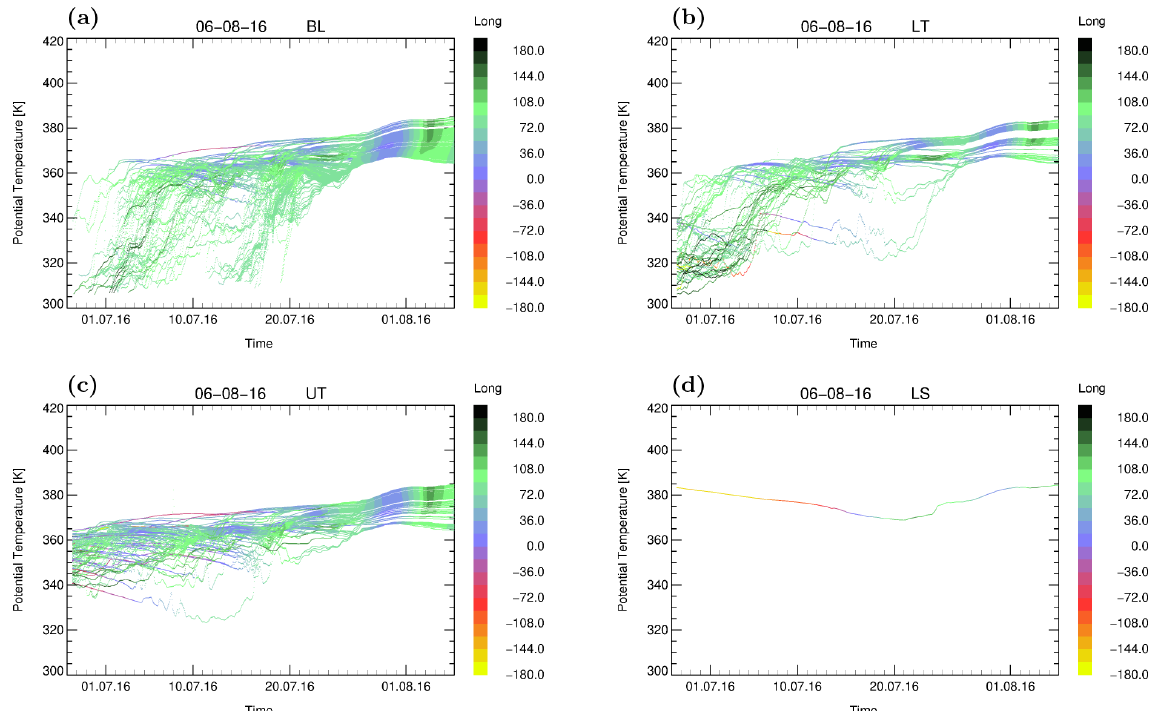
Figure 4. Forty-day backward trajectories initialised on 6 August 2016 at the location of the ATAL measurement (see Table 1). The trajec- tories are sorted by air mass origin in the boundary layer (a) , in the lower troposphere (b) , in the upper troposphere (c) and in the lower stratosphere (d) . The fractions of the different atmospheric altitude layers (BL, LT, UT, LS) of the composition of the ATAL are shown in Table 2. The colour indicates the location of the trajectory in